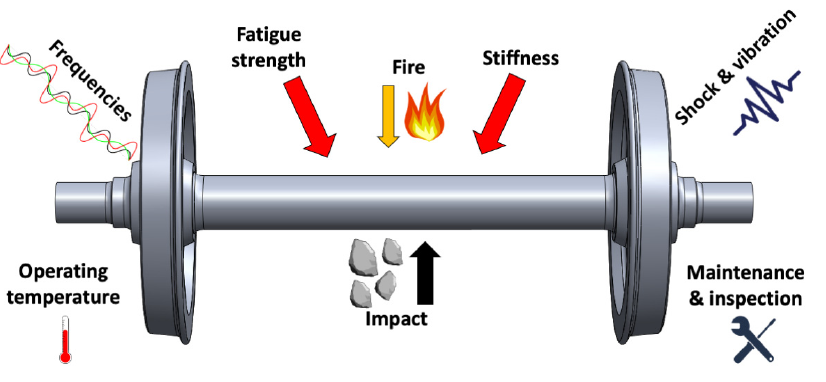
Figure 4. Structural and secondary requirements for the design of a hybrid metallic-composite wheelset.